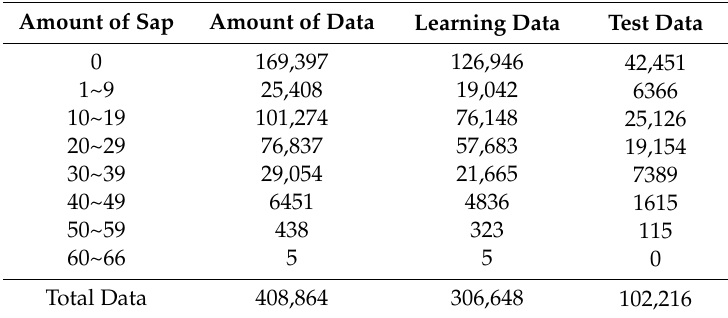
Table 2. Classification of learning data and test